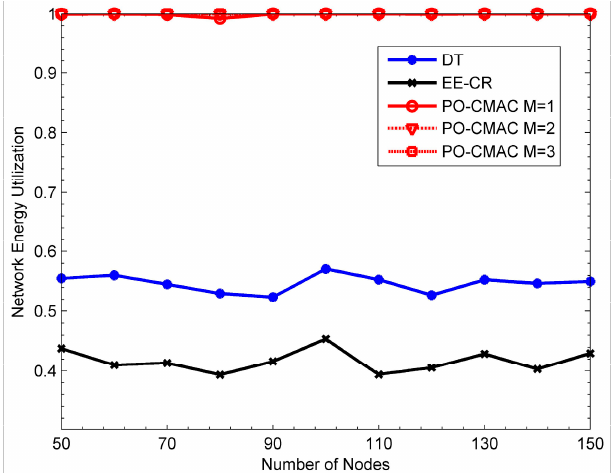
Figure 11. Network energy utilization with varying N at uniform traffic load.